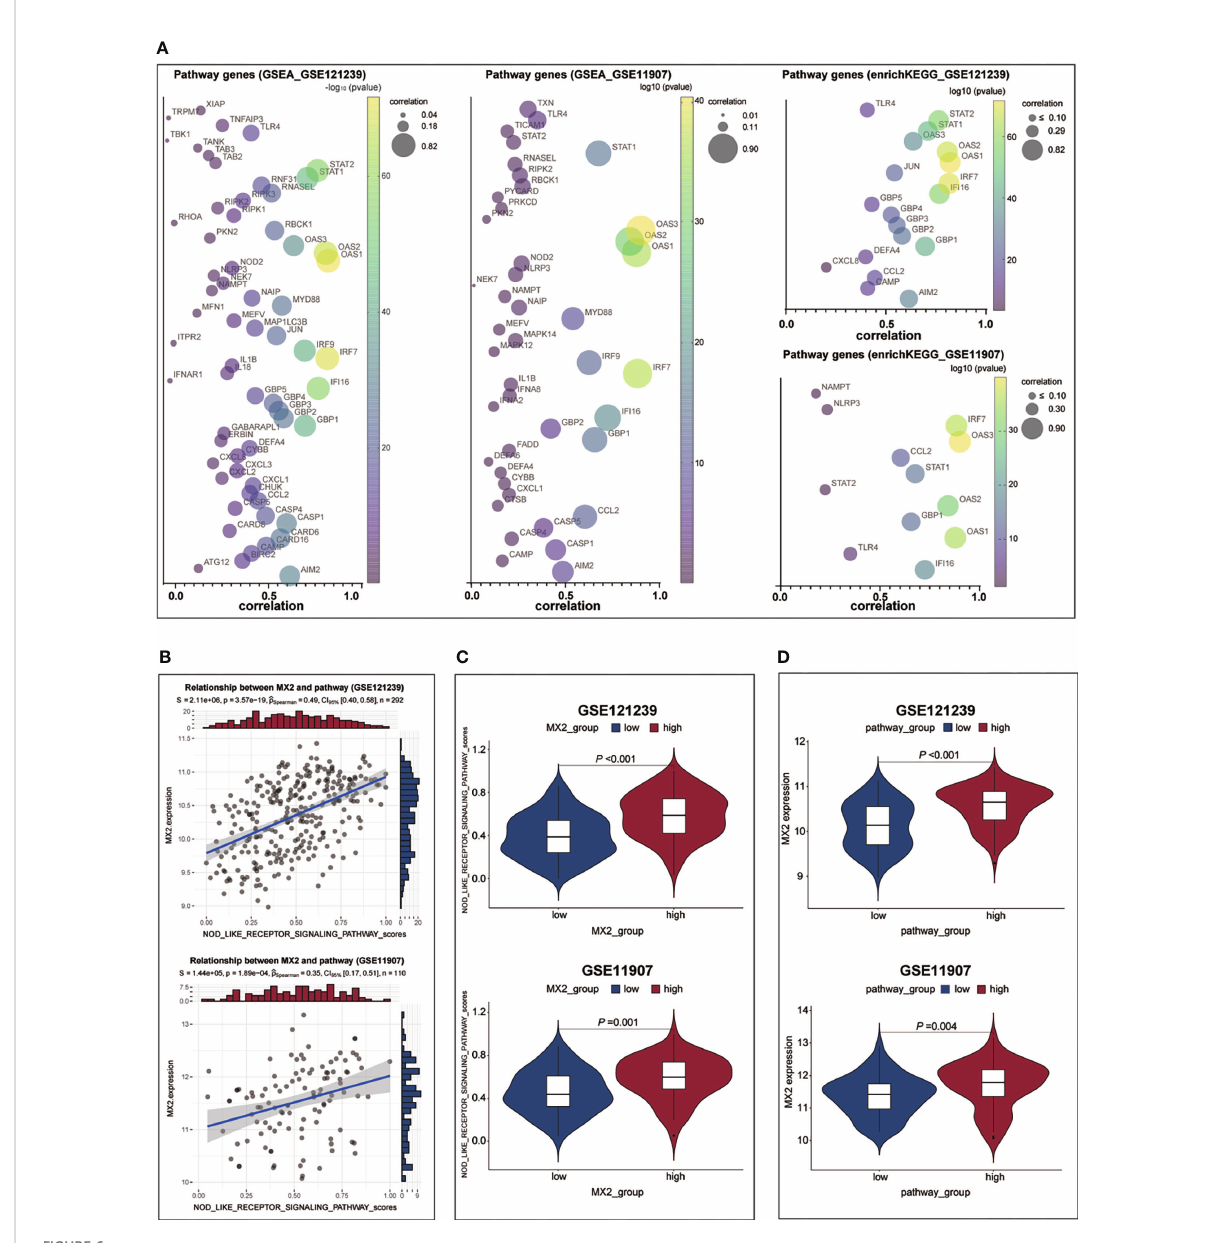
FIGURE 6 MX2 activated NOD-like receptor signaling pathway in SLE. (A) Correlation between MX2 and NOD-like receptor signaling pathway genes. (B) Correlation between MX2 and NOD-like receptor signaling pathway scores. (C) Comparison of the distribution of NOD-like receptor signaling pathway scores between high and low MX2 expression subgroups. (D) Comparison of MX2 expression between high and low subgroups of the NOD-like receptor signaling pathway